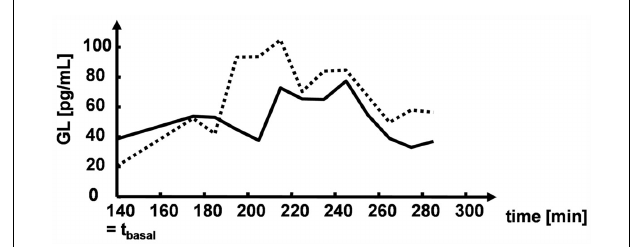
FIGURE 5 | Illustrative glucagon levels in two study participants.